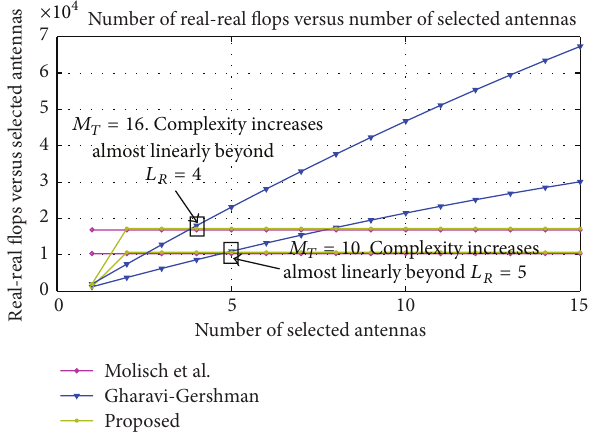
Figure 10: Plots showing the variation of real-real flops as a function ofthenumberofselectedantennasfor 𝑀 𝑇 = 16 and10and 𝑀 𝑅 = 16